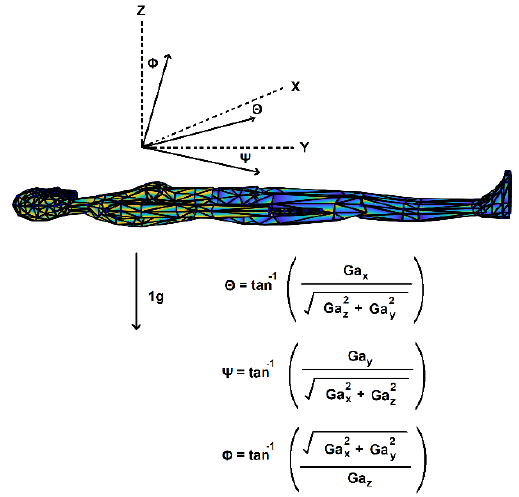
Figure 3. Using an accelerometer for inclination sensing . Angles for independent inclination sensing were computed from the gravitational component (GA) as described by Fisher [22]. Baseline tilt corrections were made based on tilt angles obtained during a supine rest position. Body segments modified from an original VRML file by Cindy Ballreich (cindy@ballreich.net) copyright 1997.